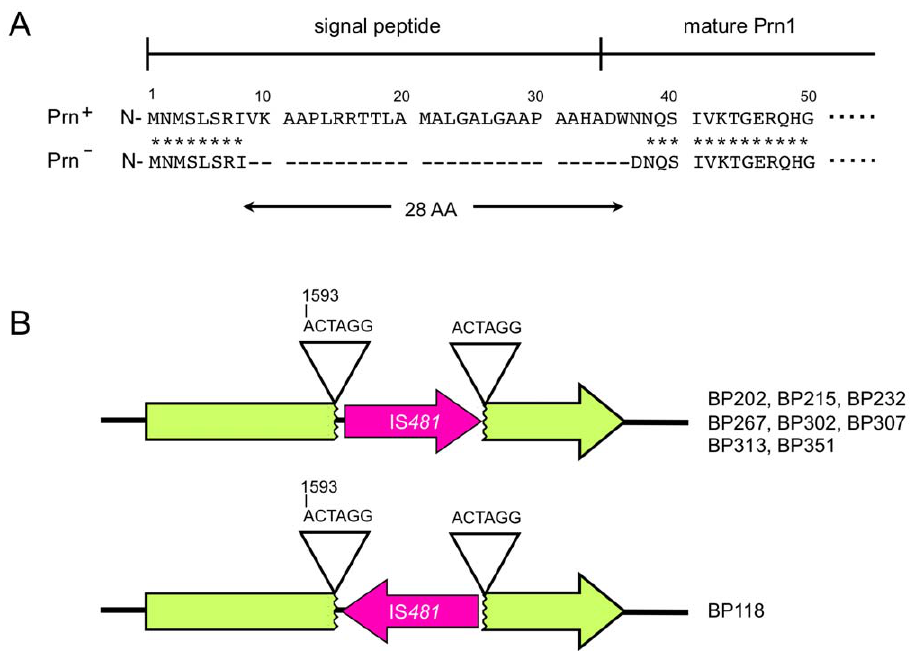
Figure 2. Molecular mechanisms of loss of Prn expression. (A) Deletion of the Prn signal sequence ( prn1 D SS). Prn 2 isolates ( n =24) have an 84-bp deletion, resulting in a 28-amino acid deletion (Val 9 to Trp 36 ) in the N-terminal region. (B) IS 481 insertion mutation in Prn1 gene ( prn1 ::IS 481 ). Eight Prn 2 isolates have an IS 481 insertion in the forward direction at the 6-bp direct repeats (ACTAGG, 1593–1598 bp) of prn1 , and 1 isolate had the insertion in the reverse.